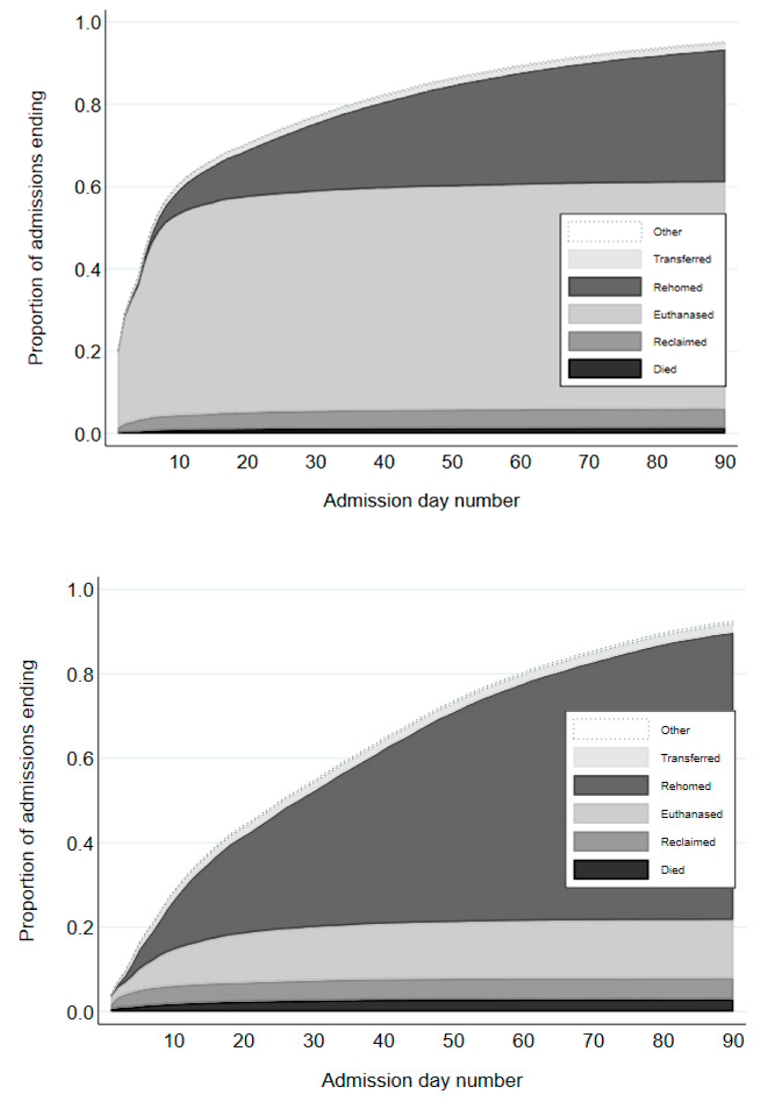
Figure 2. Stacked cumulative proportions of cat admissions to RSPCA Queensland shelters by outcome by day of admission (in which day 1 was the day the cat was admitted) for the years 2011 (upper) and 2016 (lower).